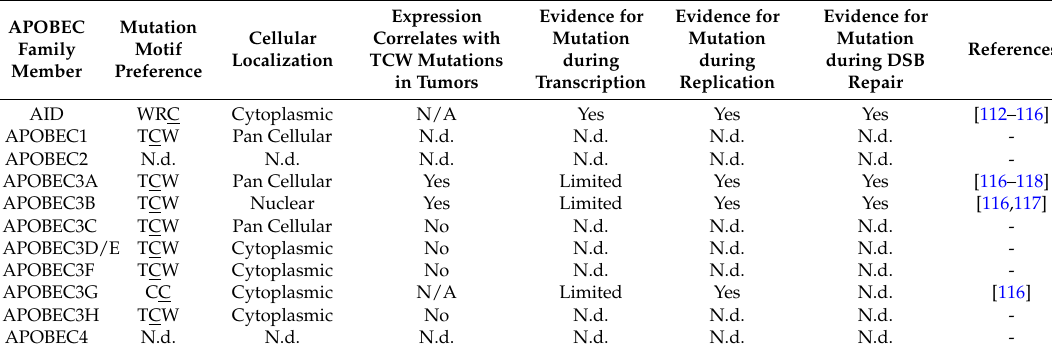
Table 2. APOBEC characteristics and their involvement in cancer